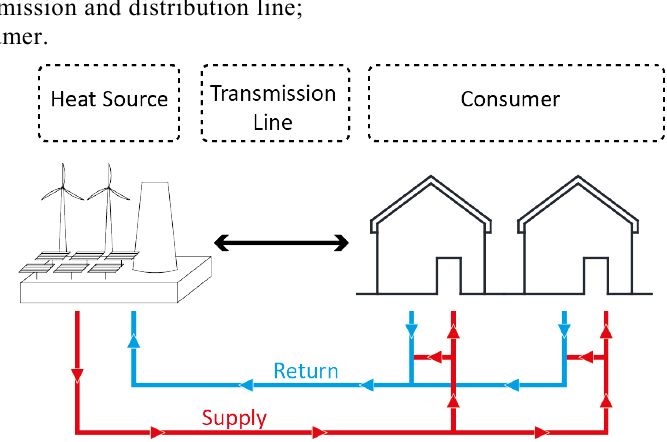
Fig. 2. A scheme of a typical District Heating